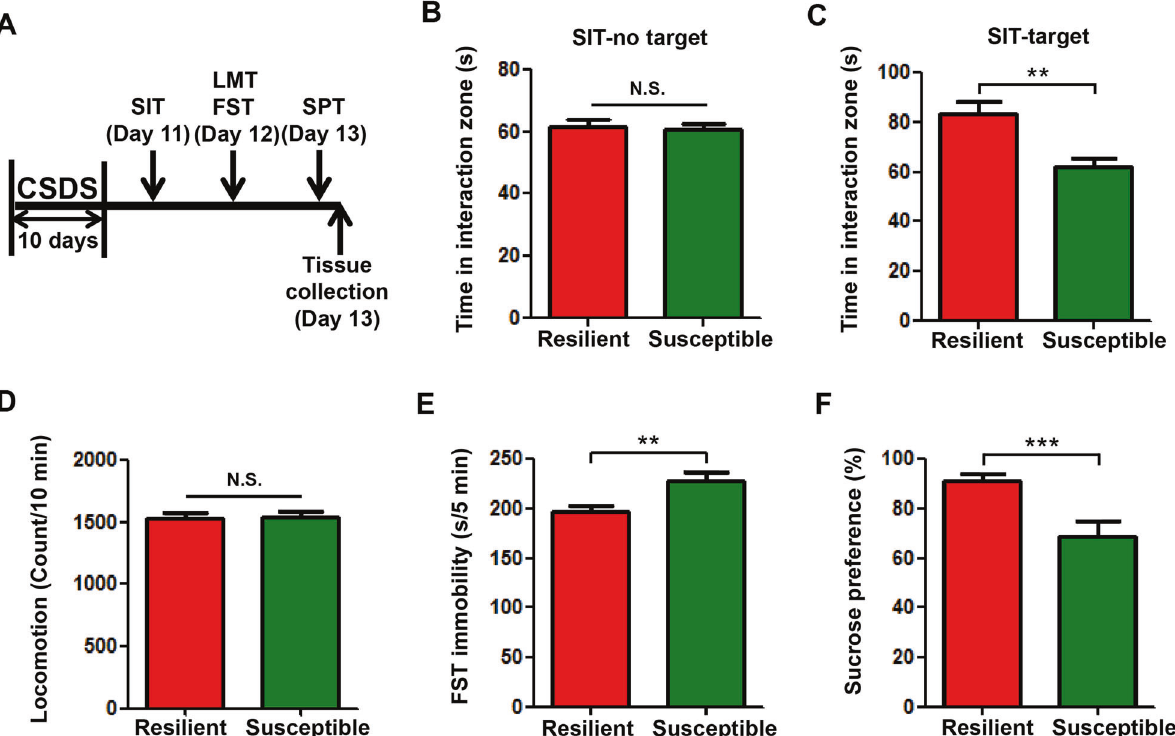
Fig. 1 The establishment of SDS mouse model. a The schedule of CSDS model and behavioral tests. b , c The time spent in the interaction zone during the SIT. SIT was performed at day 11 to segregate the defeated mice into resilient and susceptible subgroups. d – f The number of squares crossed during LMT, immobility time during FST, and sucrose-preference ratio during SPTof CSDS-resilient and -susceptible mice. LMT, FST, and SPT were performed to analyze the depression-like behaviors of CSDS-resilient and -susceptible mice at day 12 and day 13. Data are shown as mean ± SEM ( n = 8). ** P < 0.01, *** P < 0.001, N.S. not signi fi